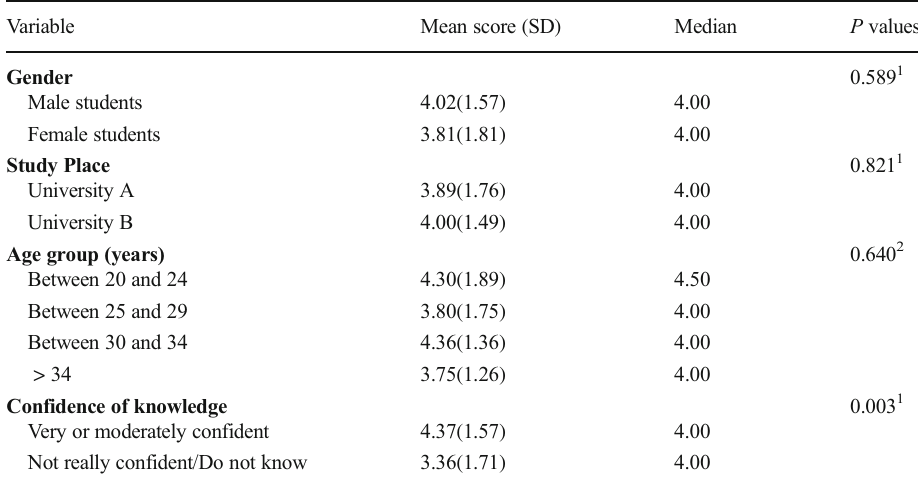
Table 2 Mean score (SD), median and P values